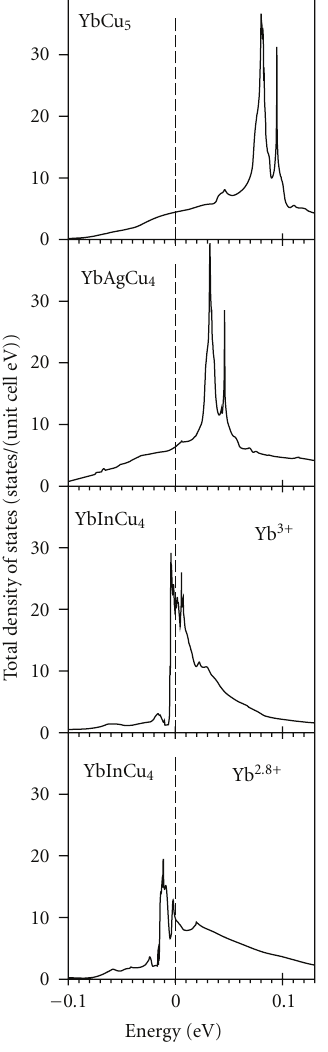
Figure 97: Expended view of the total DOS N( E ) of YbCu 5 , YbAgCu 4 , and YbInCu 4 (for Yb 3+ and Yb 2 . 8+ configurations) cal- culated in the LSDA+ U approximation